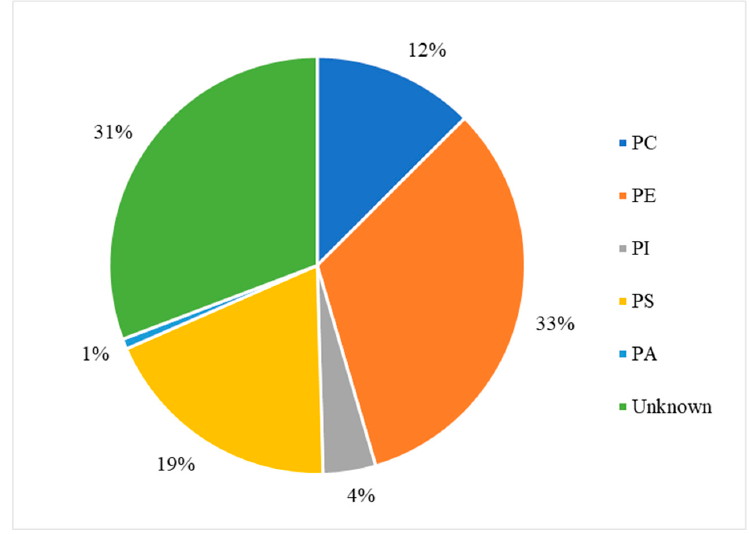
Figure 10. Lipid composition of porcine brain polar extract. Adapted from Avanti polar lipids; https://avantilipids.com/product/141101.